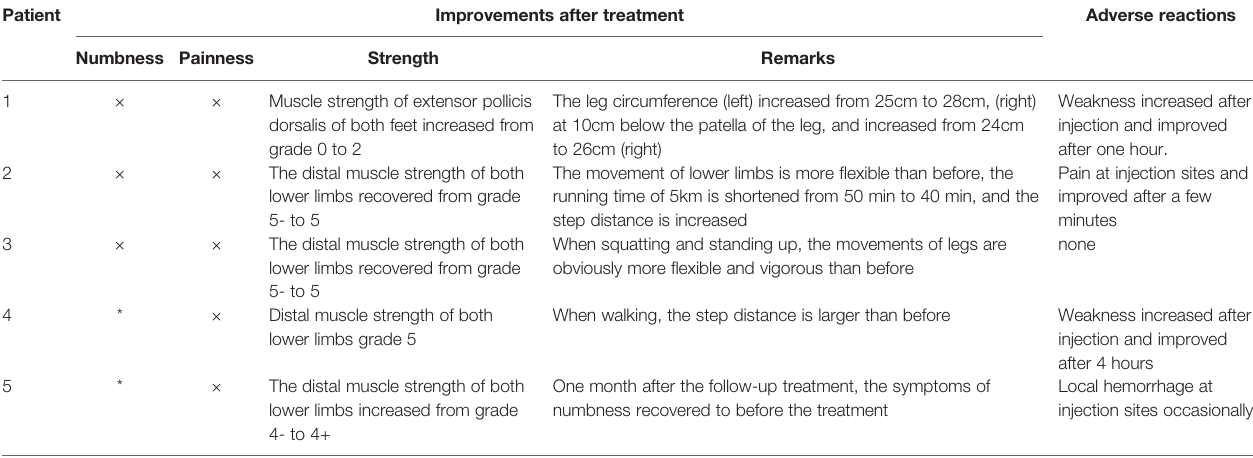
TABLE 4 | Clinical manifestation changes after